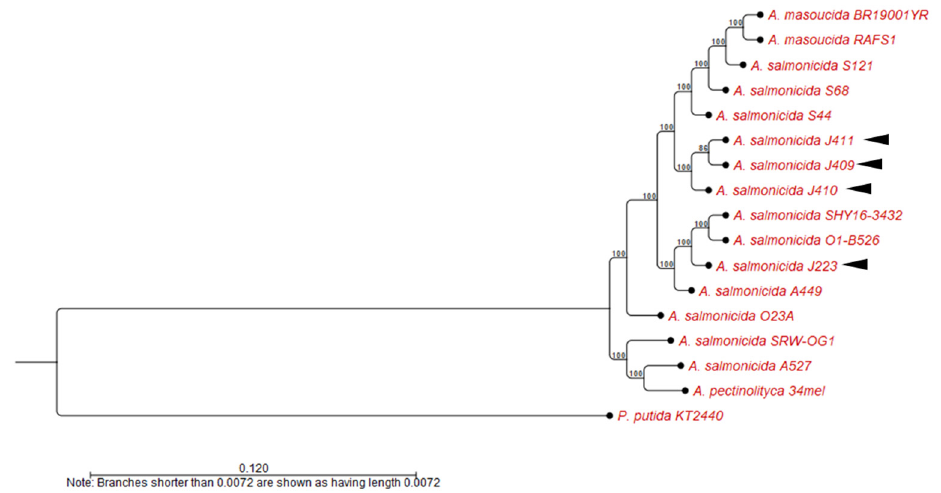
Figure 5. A. salmonicida phylogenetic analysis. Phylogenetic history of A. salmonicida genomes. Evolutionary history was calculated using neighbor-joining method, with a bootstrap of 500 replicates for taxa analysis. Evolutionary distances were computed by the Jukes–Cantor method. Ambiguous positions were removed with the pairwise deletion option. Analysis was computed using CGWB.